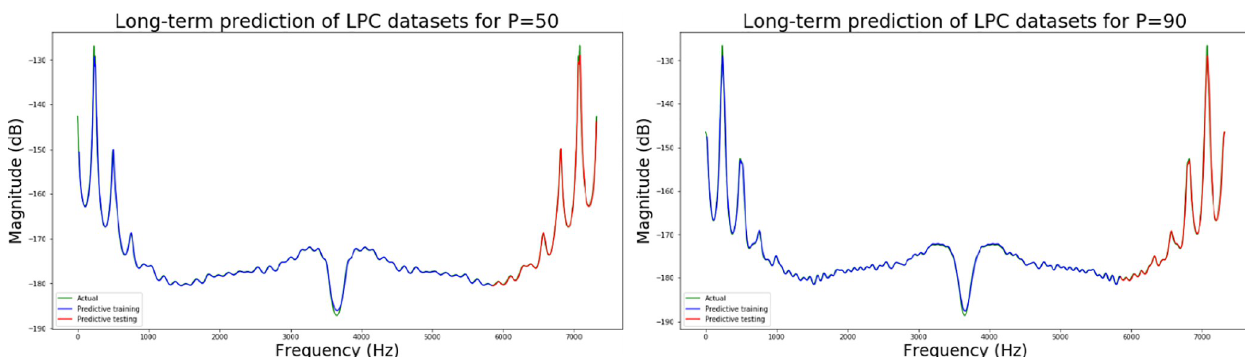
Fig 29. (a) It shows the predictive coefficient in the LPC feature datasets is 50 of the long-term prediction; (b) It shows the predictive coefficient in the LPC feature datasets is 90 of the long-term prediction.